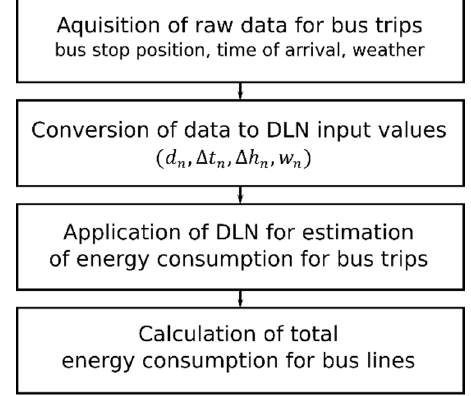
Figure 5. Block diagram of the estimation method.